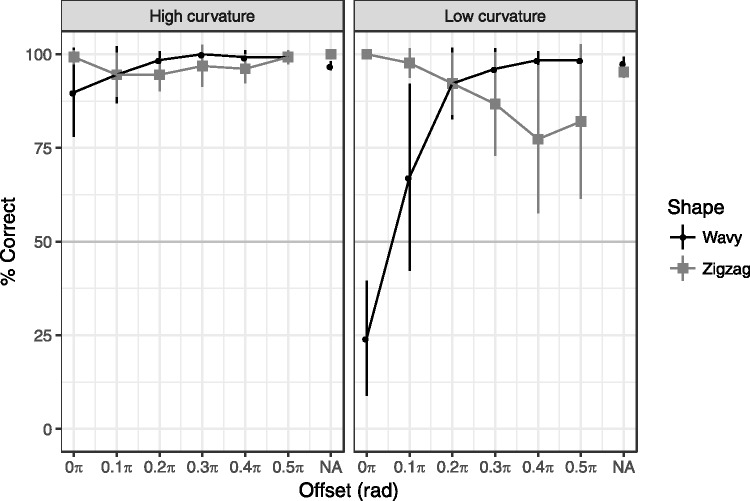
Results of Experiment 1. The chance level was 50% (horizontal gray line). An accuracy rate higher than chance indicates that the percepts were veridical; an accuracy rate lower than chance indicates that the percepts were illusory. Error bars indicate 95% confidential intervals.